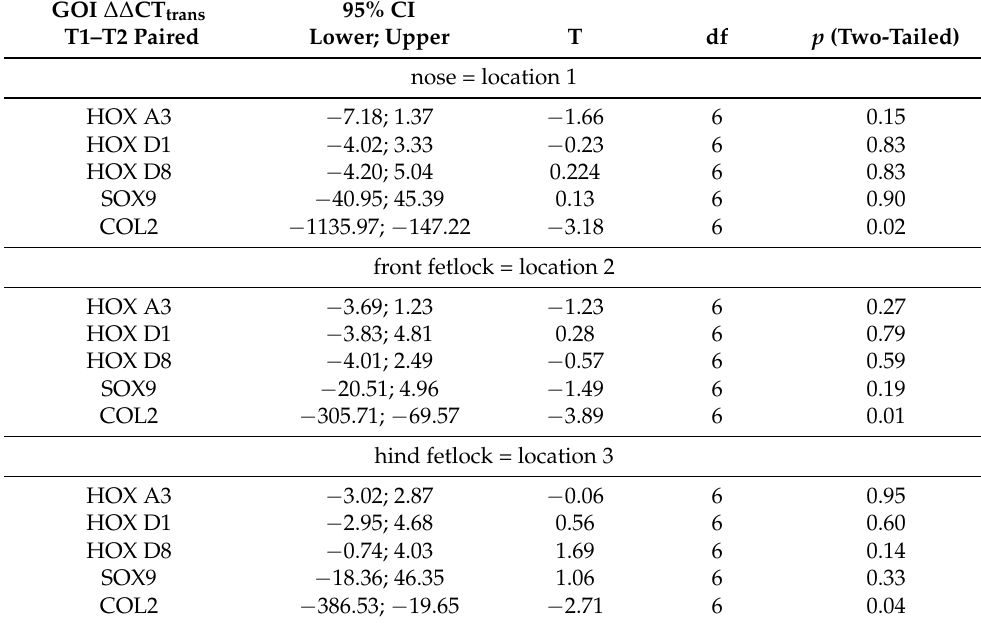
Table 8. Results of two-tailed paired t-test for ∆∆ CT trans in each location, with confidential interval (CI), difference (T), degrees of freedom (df) and significance levels ( p